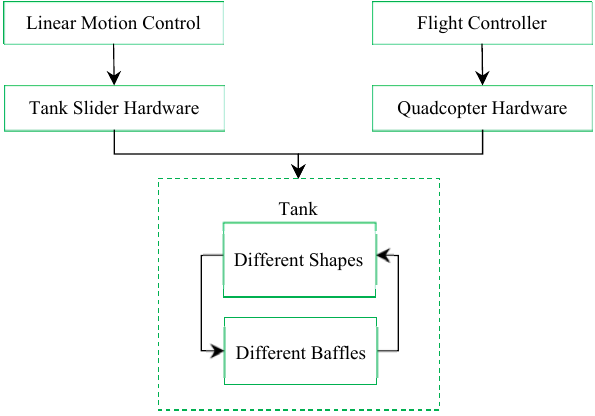
Figure 2. System architecture of our study.